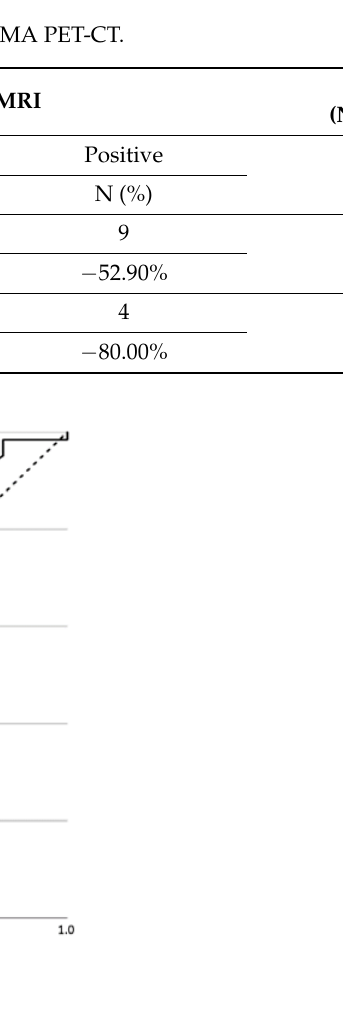
6 of 11 Table 5. Comparison between mpMRI and Ga-PSMA PET-CT.